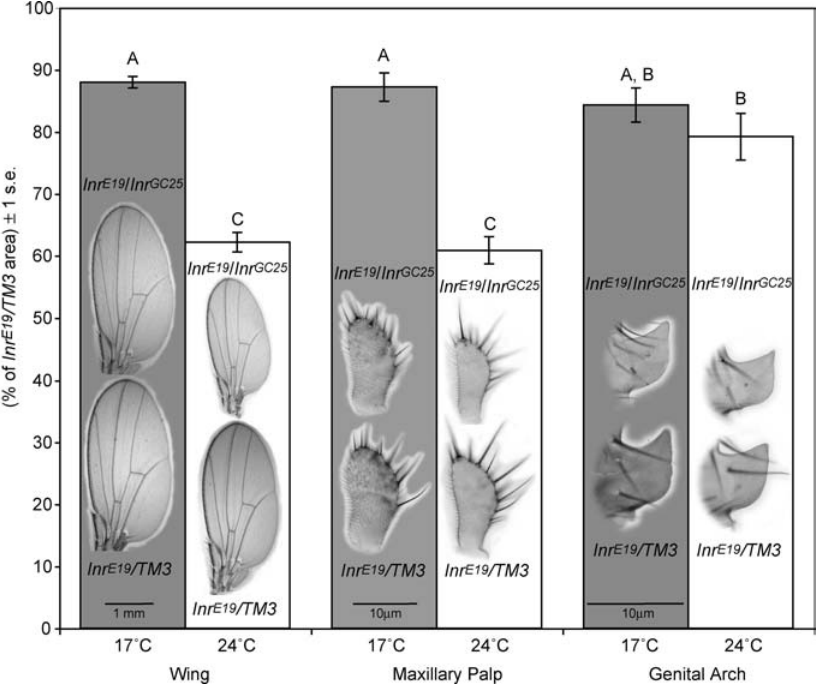
Figure 5. Different Organs Respond Differently to Suppression of Inr Activity Bars show organ area in Inr E19 /Inr GC25 males as a percentage of area in Inr E19 /TM3 males, to control for temperature effects. Bars with different letters indicate organs that differ: A, B, and C are significantly different at a ¼ 0.05 (Tukey-Kramer pairwise comparison). Mean areas of all organs given in